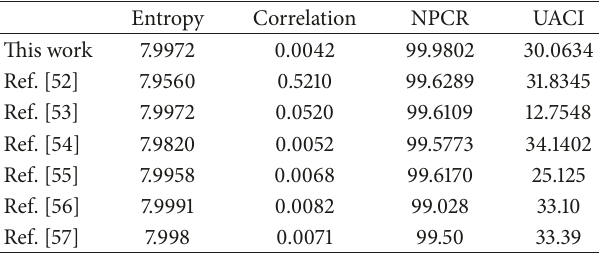
Table 2: Security analysis result and comparisons (256 × 256 “pepper” image).